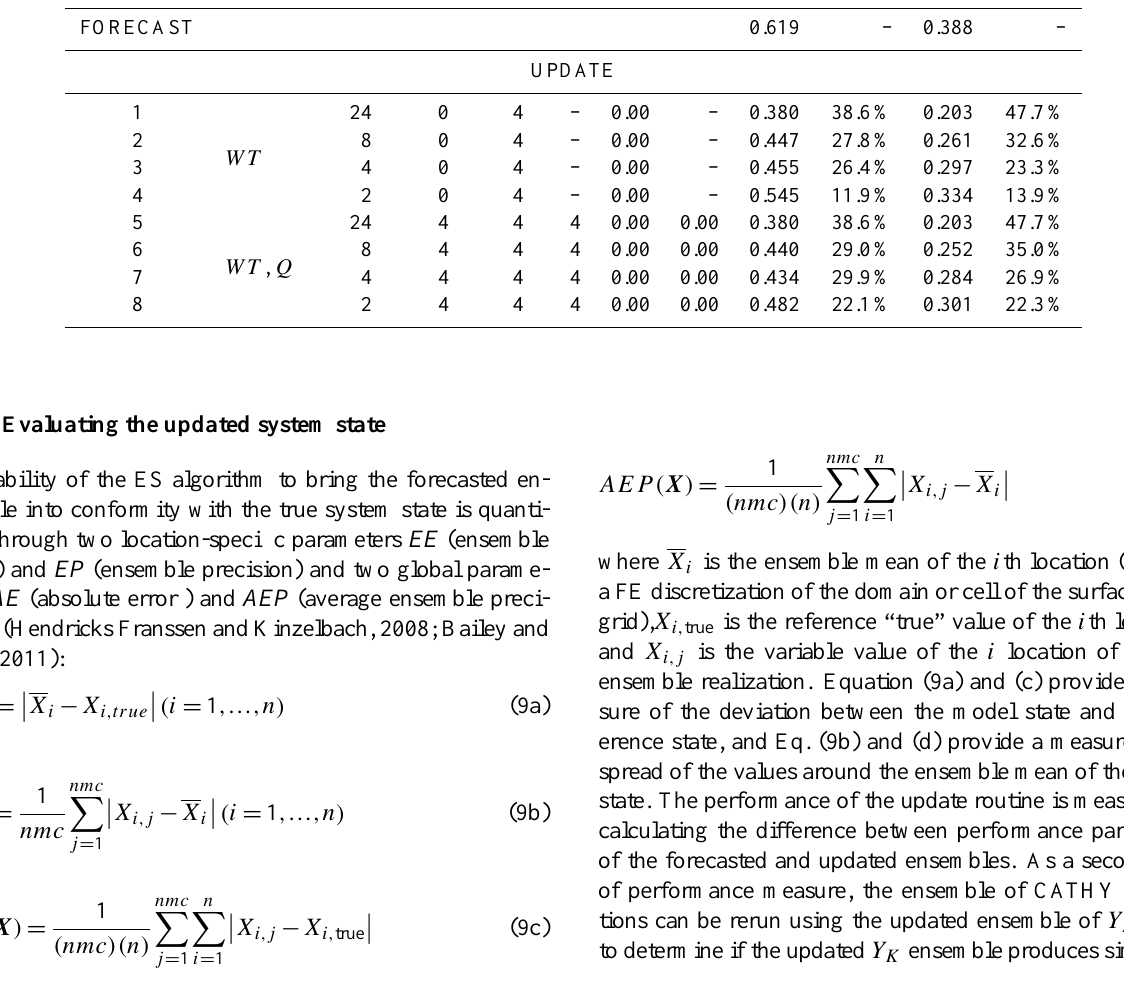
Table 3. Spatial distribution of the mean of the updated Y K ensemble using Y Q data from four gaging stations along the stream channel sampled four times during the 365-day period, with the CV of observation data set to 0.0. Compare to the true state shown in Fig. 5a.